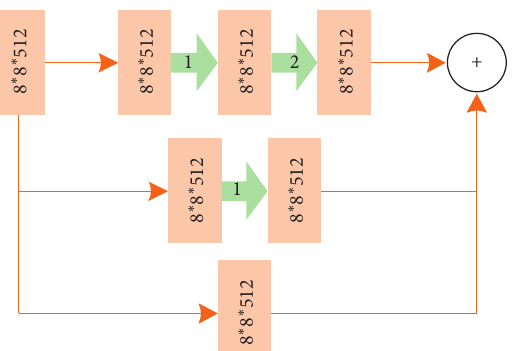
Figure 4: The unrolled structure of the center dilation part of D-LinkNet. From top to bottom, the receptive fields are 7, 3, and 1,